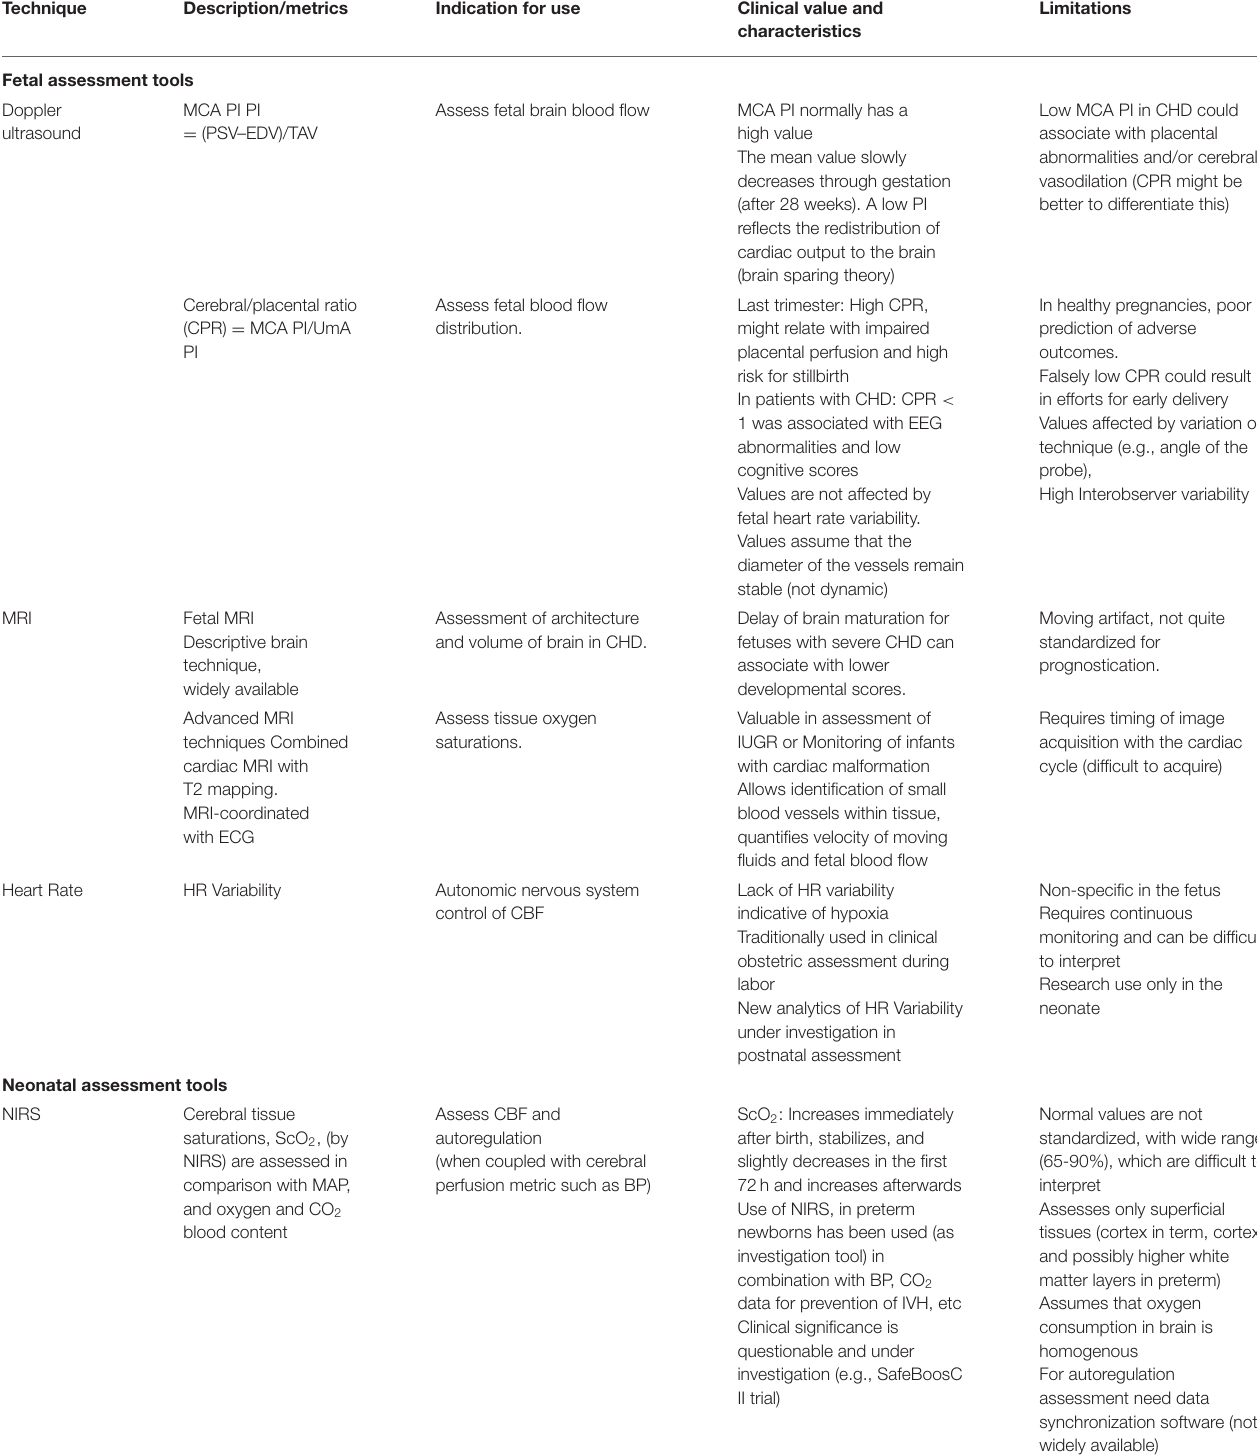
TABLE 1 | A brief description, indication for use, clinical significance, and limitations of key diagnostic studies in newborns at risk for cerebral injury.